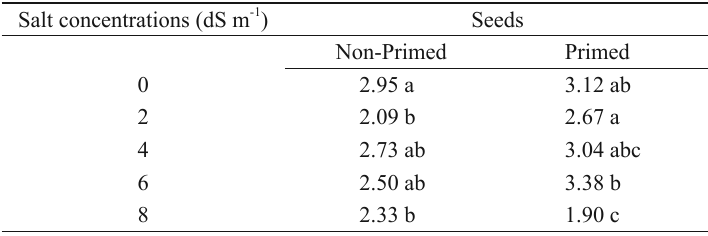
Means followed by same lower-case letter in a column do not differ by